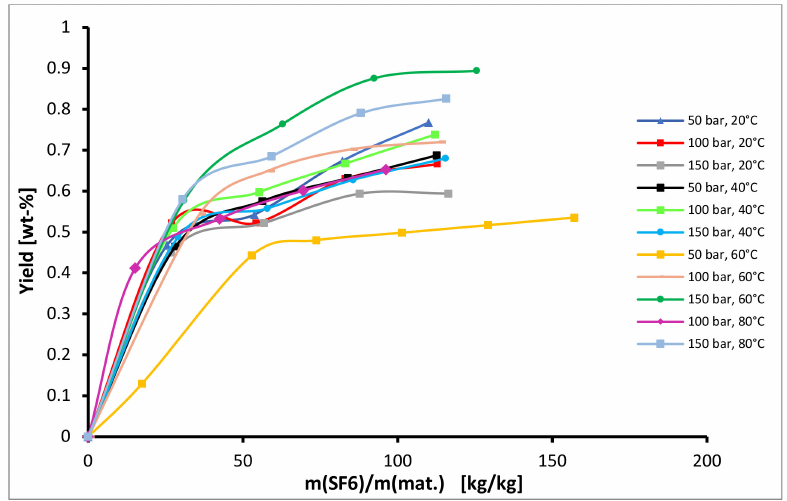
Figure 4. Kinetics of semi-continuous extraction of hops with SF 6 .